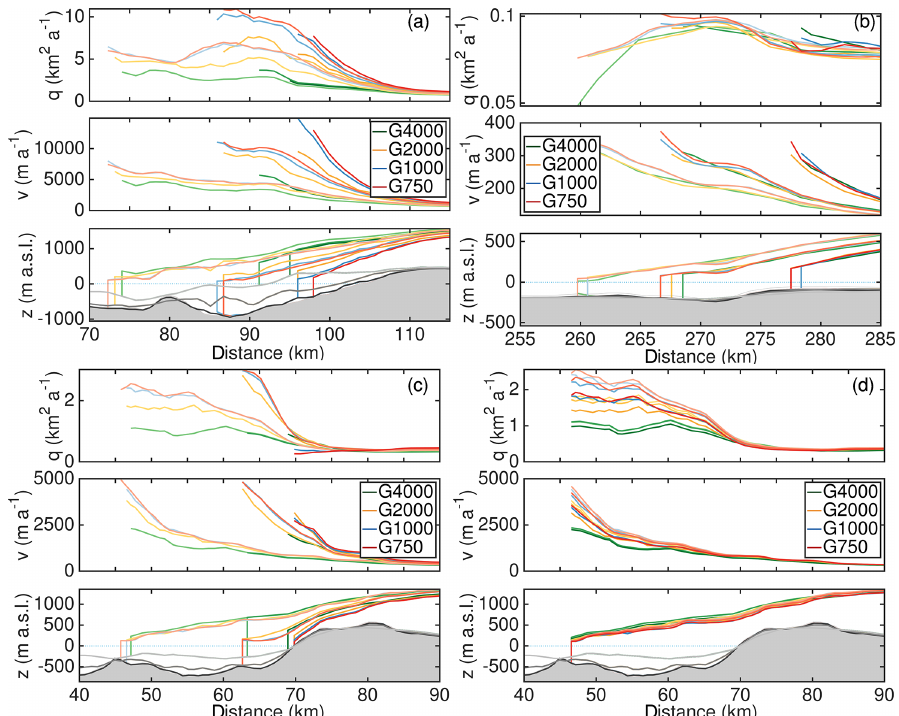
Figure 11. Response of outlet glaciers. Colour scheme is the same as in previous figures, and light to dark colours indicate the years 2015, 2070 and 2100. (a) Helheim Glacier under RCP8.5-Rhigh forcing. (b) Humboldt Glacier under RCP8.5-Rhigh forcing. (c) Store Glacier under RCP8.5-Rhigh forcing. (d) Store Glacier under RCP8.5-Rnone forcing. Upper rows show the transient behaviour of the ice discharge q , the middle rows the surface velocity v and lower rows the evolution of the ice geometry. In the lower rows, the grey-shaded area depicts the bedrock topography from the G750 simulation. The grey lines from dark to light indicate the bedrock topography from the G1000, G2000 and G4000 simulation. None of the quantities are corrected with the ctrl run. Distance is relative to an arbitrary